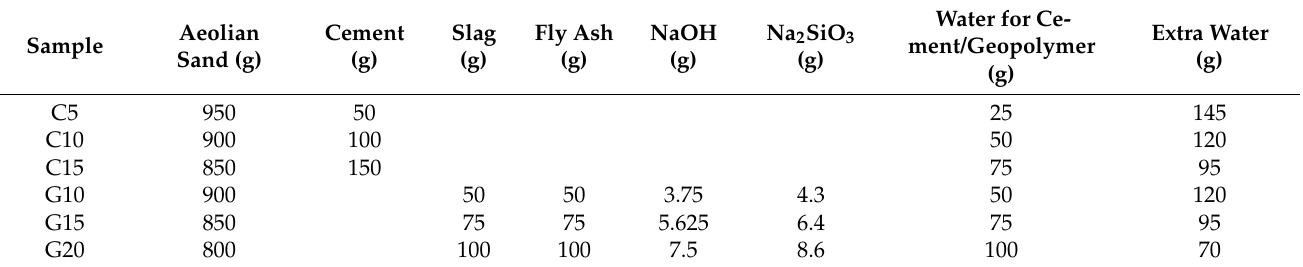
Table 3. Mix compositions of solidified aeolian sand